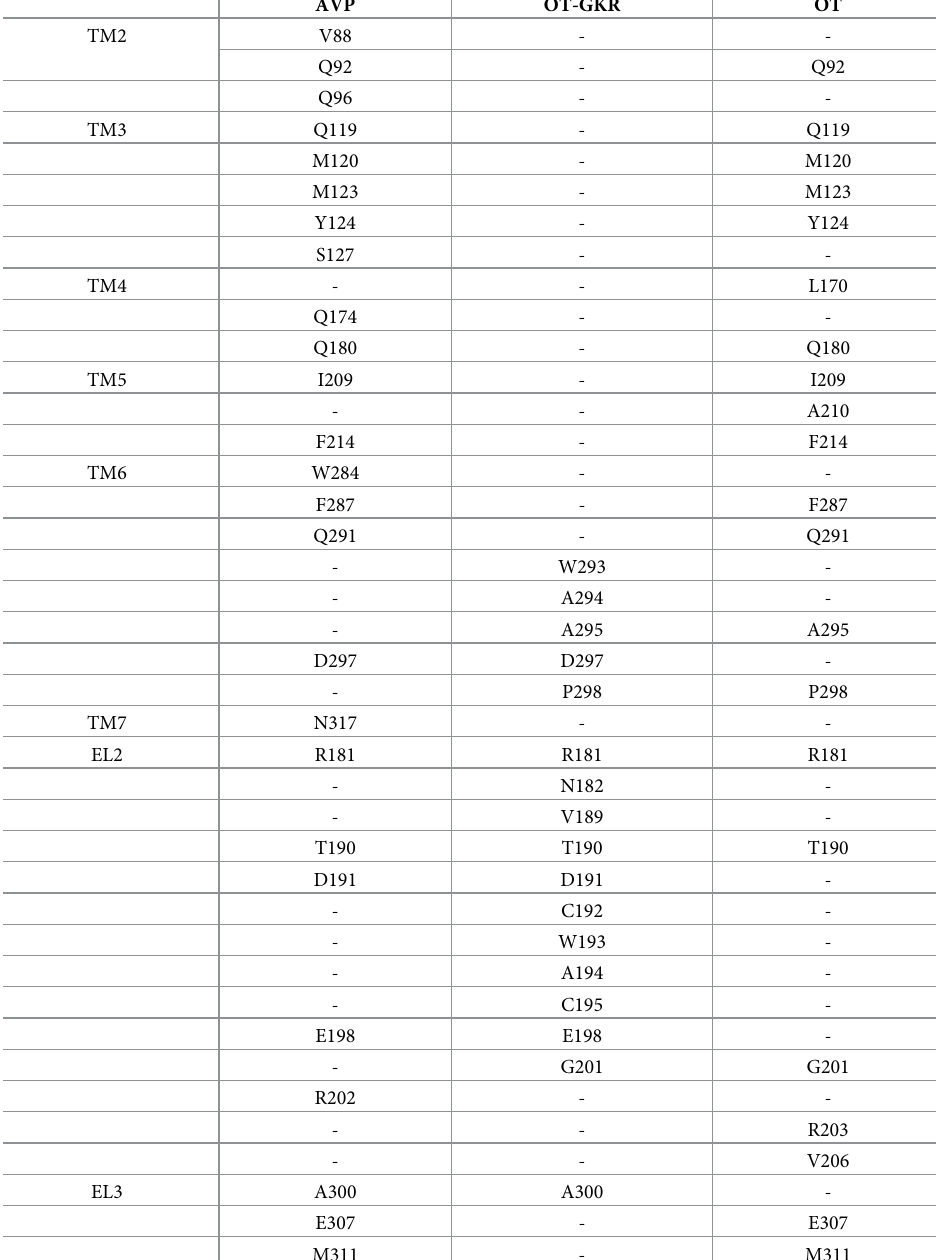
Table 1. List of the V 2 R residues interacting with arginine-vasopressin (AVP), oxytocin (OT) and carboxy- extended form of oxytocin–OT-GKR.